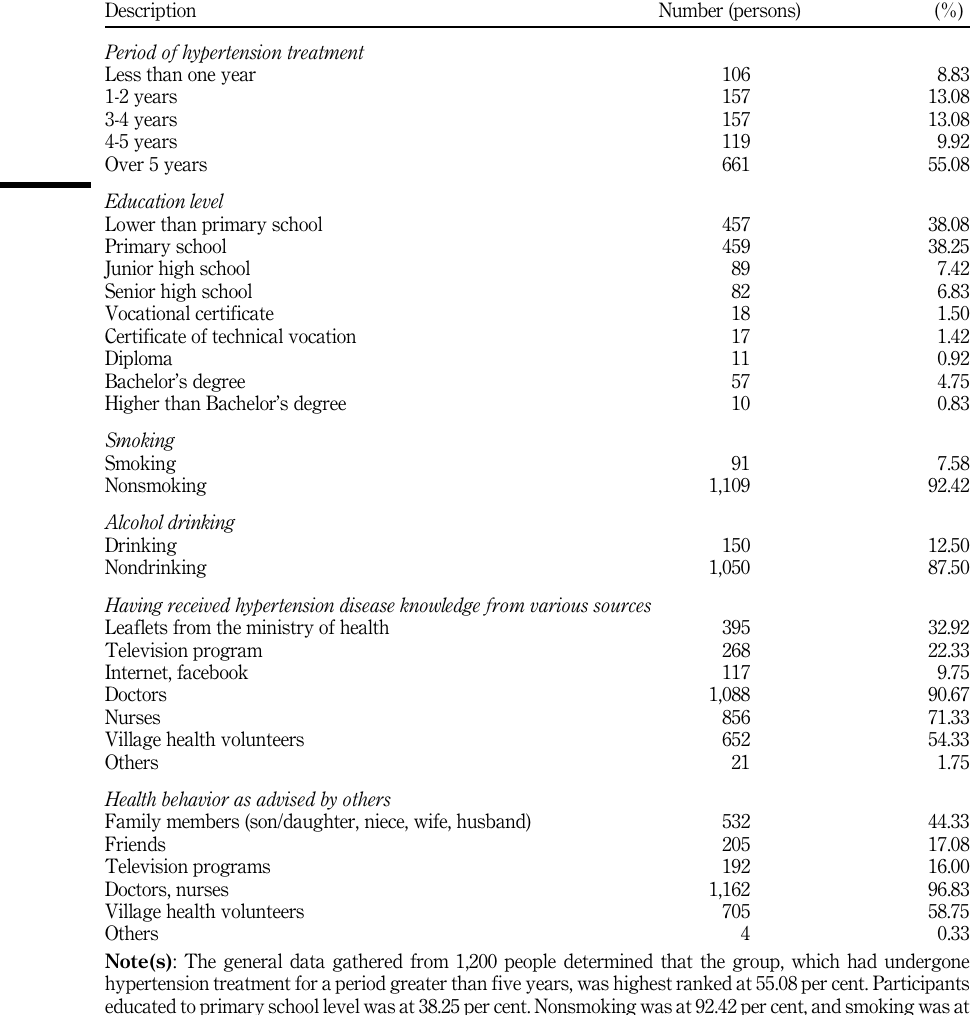
Table 2. General data of the sample group of 1,200